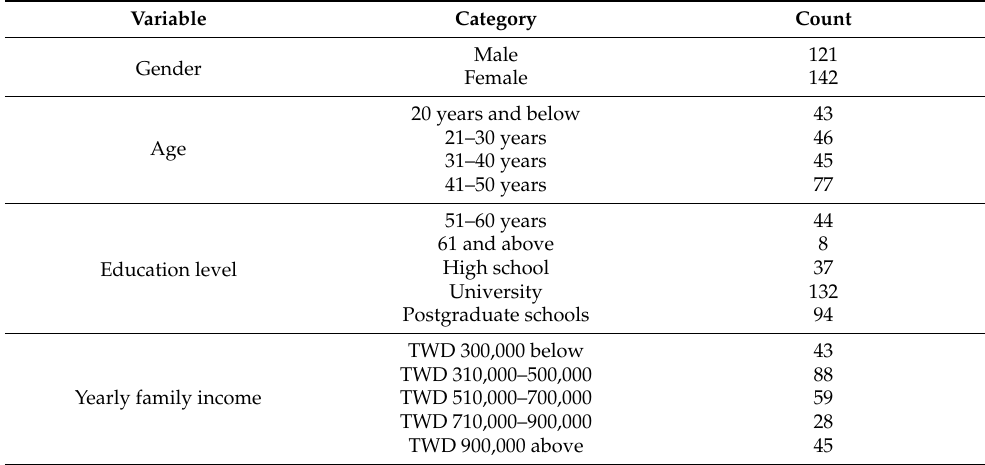
Table 1. Analysis of sample characteristics.